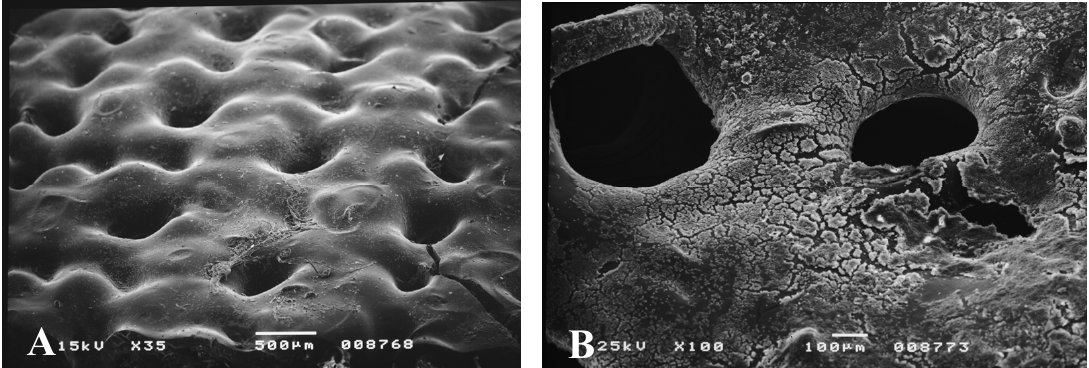
FIGURE 2 - Electron photomicrographs of the latex prosthesis with porous polyamide.: A – Inclined panoramic view of the surface of the 1-mm thick biomembrane (35x). B - Inclined panoramic view of the surface of the 0.5-mm thick biomembrane (100x). Reproduced from Mrué et al . 13 , with permission